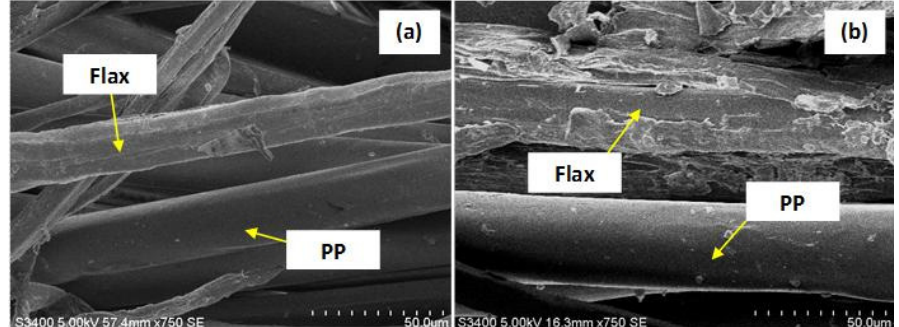
Figure 6. SEM images of surface morphology of ( a ) Flax/PP, ( b ) Pm-Flax/PP (150 W) fabrics. Flax/PLA